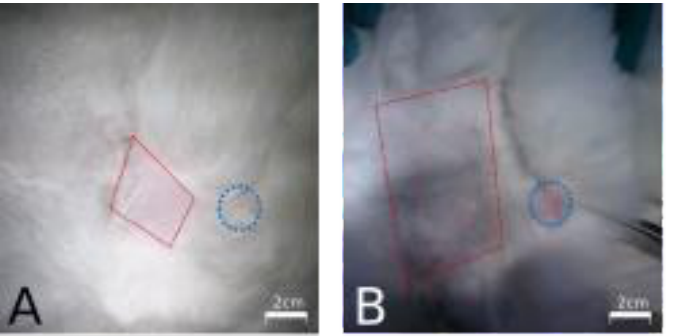
Figure 2. Rabbits skin regions expose to internal brachytherapy. ( A ) Representative picture of a rabbits treated with P144. ( B ) Representative picture of a rabbits treated with placebo. Skin area affected with post brachytherapy alopecia is indicated with discontinued red line square and catheters insertion point is indicated with a discontinued blue